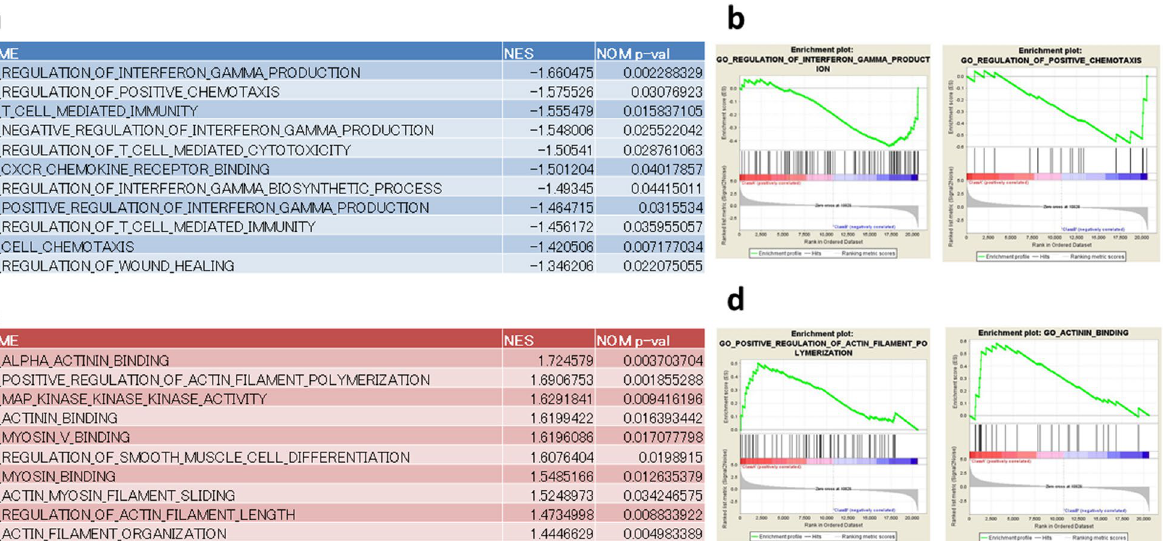
Figure 3. Gene set enrichment analysis (GSEA). ( a ) Representative list of impoverished gene sets upon knockdown of PAX3-FOXO1 and B7-H3 . ( b ) Enrichment plot from the GSEA. Interferon gamma production (left panel) and chemotaxis (right panel). ( c ) Representative list of enriched gene sets upon knockdown of PAX3-FOXO1 and B7-H3 . ( d ) Enrichment plot from the GSEA. Actin filament polymerization (left panel) and actin binding (right